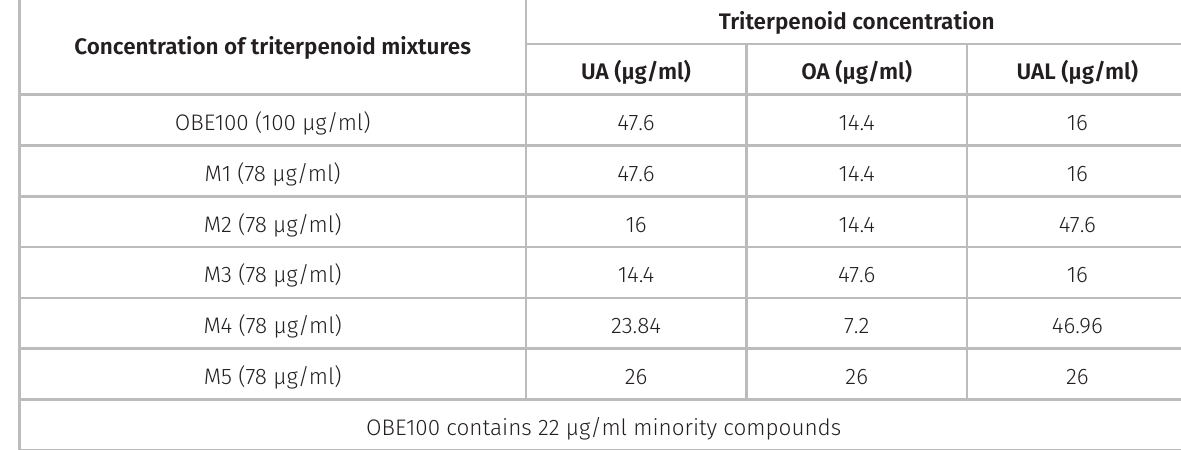
Concentration of triterpenoid